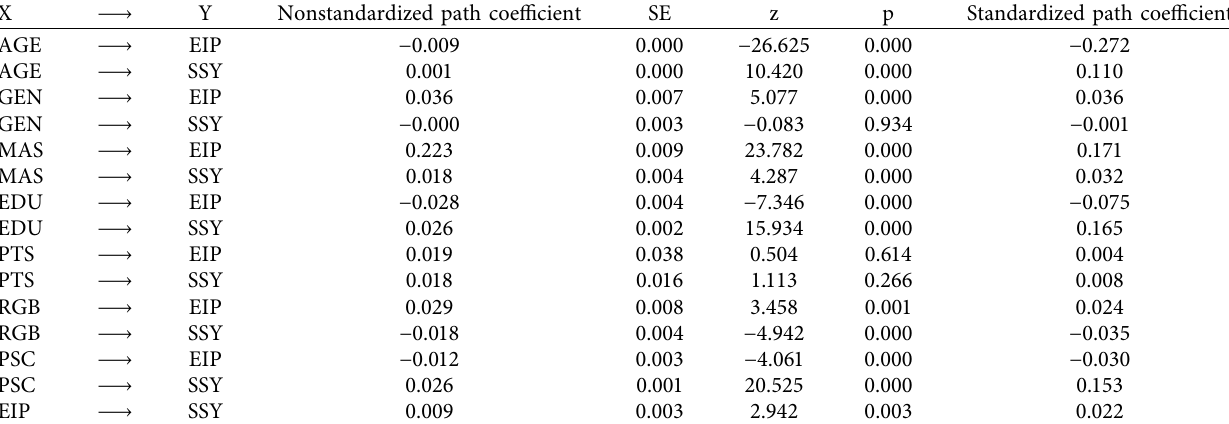
Table 4: Estimation results of the impact of endowment insurance on sense of security